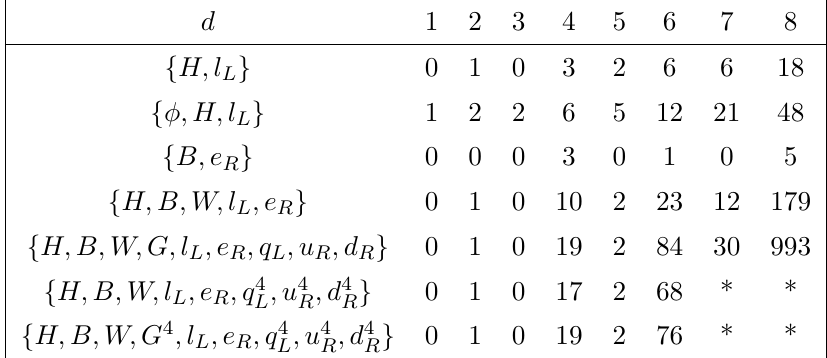
Table 2 . The number of independent operators at each mass dimension d , for various combina- tions of (cid:12)elds. f H; B; W; G; l L ; e R ; q L ; u R ; d R g are those of the one generation Standard Model